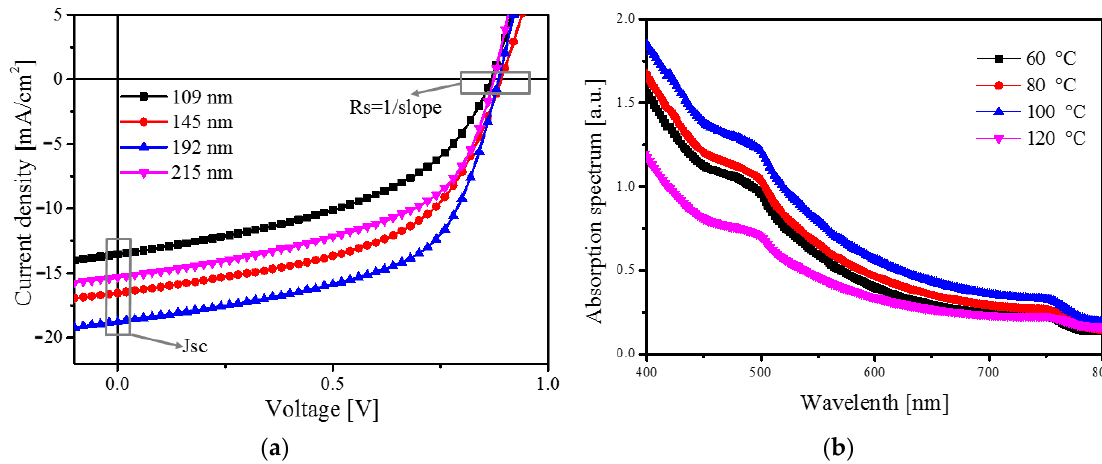
Figure 8. ( a ) Current density-voltage (J-V) characteristics of the detectors based on a MAPbI 3 layer annealed at temperature 100 ◦ C, and ( b ) curve fitting of the logarithmic J-V characteristics of the detectors in the dark. Table 2. J SC , R S and mobility of the detector based on MAPbI 3 layer with di ff erent thicknesses at an annealing temperature 100 ◦ C. Layer Thickness